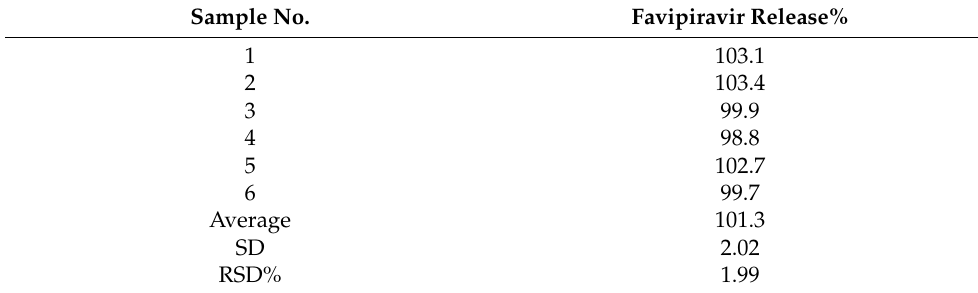
Table 6. Results of repeatability.